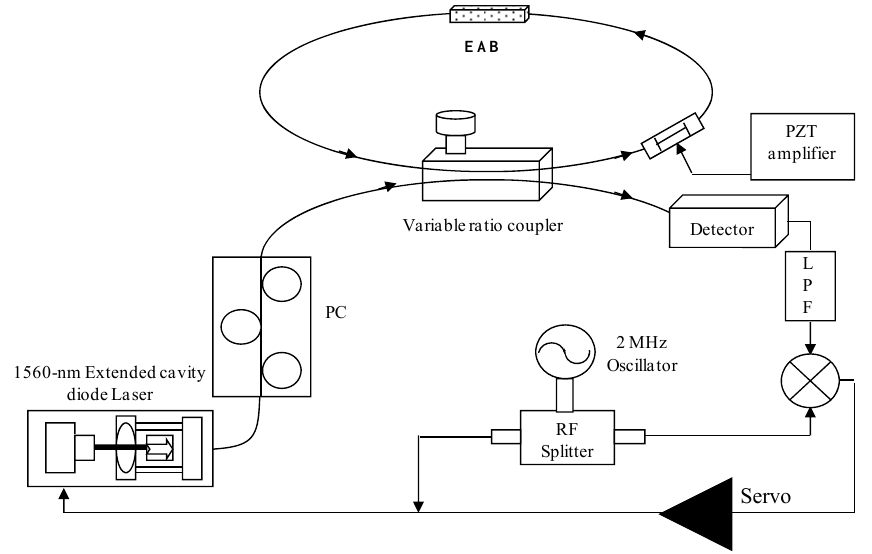
Figure 19. Schematic of the fiber-ring resonator. PC: polarization controller; EAB: evanescent-access block; LPF: low-pass filter.